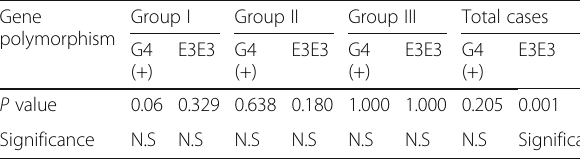
Table 11 Statistical significance for relation between echocardiography findings severity versus gene polymorphism (G4 and E3E3) in each group and total cases Gene Group I polymorphism